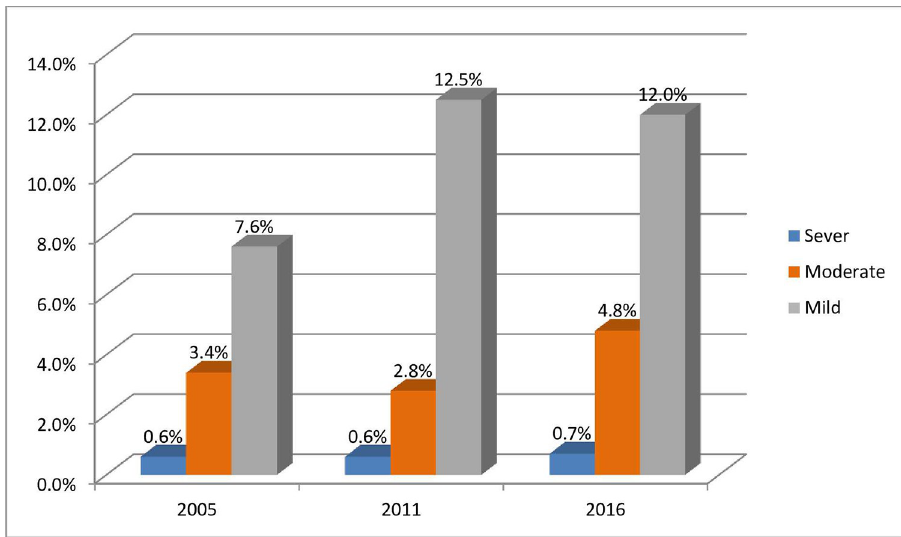
Fig 3. Severity of anaemia among women of reproductive age group from